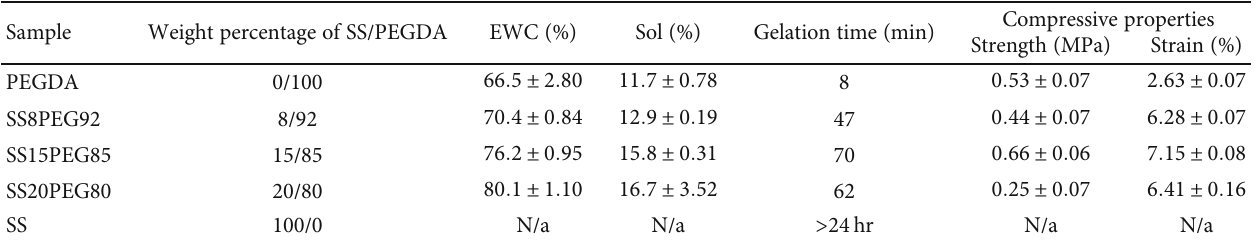
Figure 2: Time evolution of storage modulus ( G ′ ) and loss modulus ( G ″ ) of (a) PEGDA and (b) SS15PEG85 during their gelation at 25 ° C. The time where G ′ and G ″ crossover is denoted as t (gelation time). gel Table 2: Various properties of the hydrogel